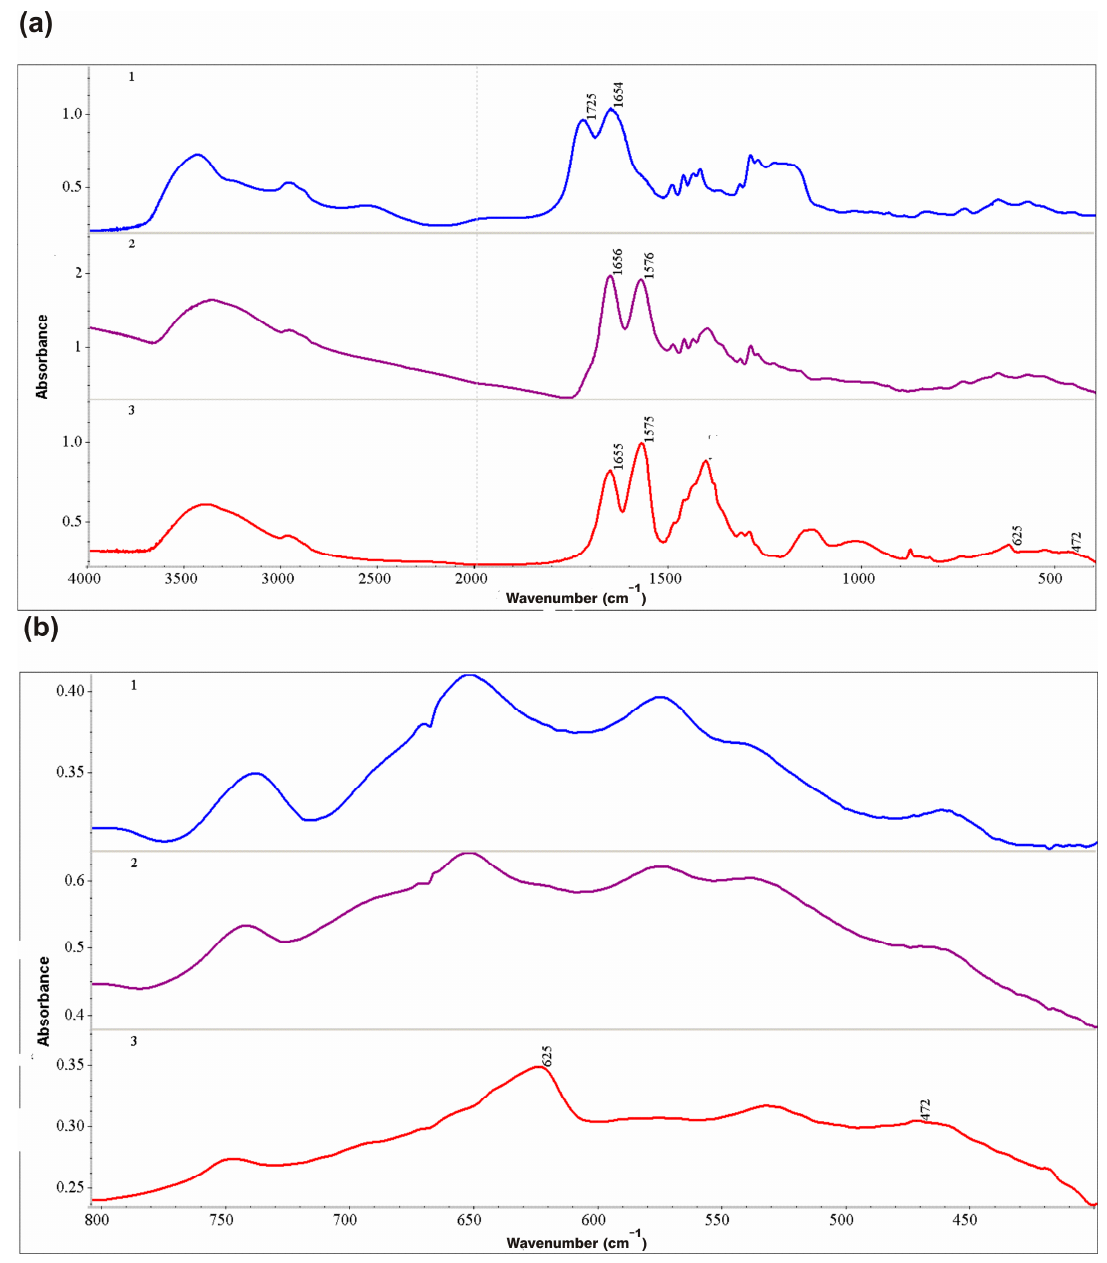
Figure 3 . ( a , b ). FTIR spectra of VM (1), VM/Ag 0 (2) and VM/Ag 0 /ZnO (3) (two wavelength ranges). A noticeable change in the spectrum of VM/Ag 0 and VM/Ag 0 /ZnO, in contrast to that of VM, is associated with the position of the C=O bond of the carboxyl group. In the compound VM, C=O stretching vibration at 1725 cm − 1 corresponds to non-ionized carboxyl groups of maleic acid residues. In VM/Ag 0 and VM/Ag 0 /ZnO compounds, C=O stretching vibration at 1575 – 1576 cm − 1 corresponds to the ionized form of carboxyl of the maleic acid residues of the copolymers since the copolymers are present in the form of a sodium salt [72]. For other polymers-stabilizers, this band is in the range 1560 – 1565 cm − 1 (Figure S5a). Since the zinc oxide content in all the studied heterostructures is small (approximately 4 – 5%, weight), for greater clarity, the area of 400 – 800 cm − 1 is presented in more detail in Figure 3b. The region 700 – 800 cm − 1 shows the deformation non-planar oscillation of C-H bonds [72]. Occurrence of the at 472 cm − 1 is characteristic of the formation of Zn-O bond (Figure 3b) [33,73]. Earlier for ZnO crystals, Zn-O stretching mode has also been observed